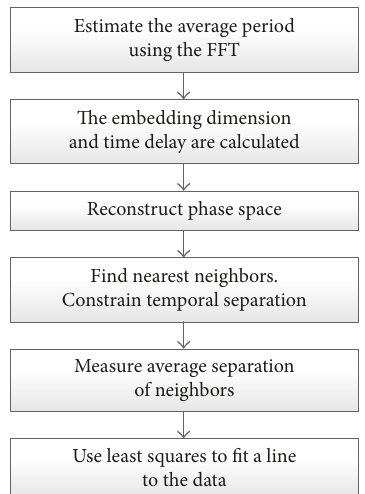
Figure 14: Flowchart of the small data sets method.